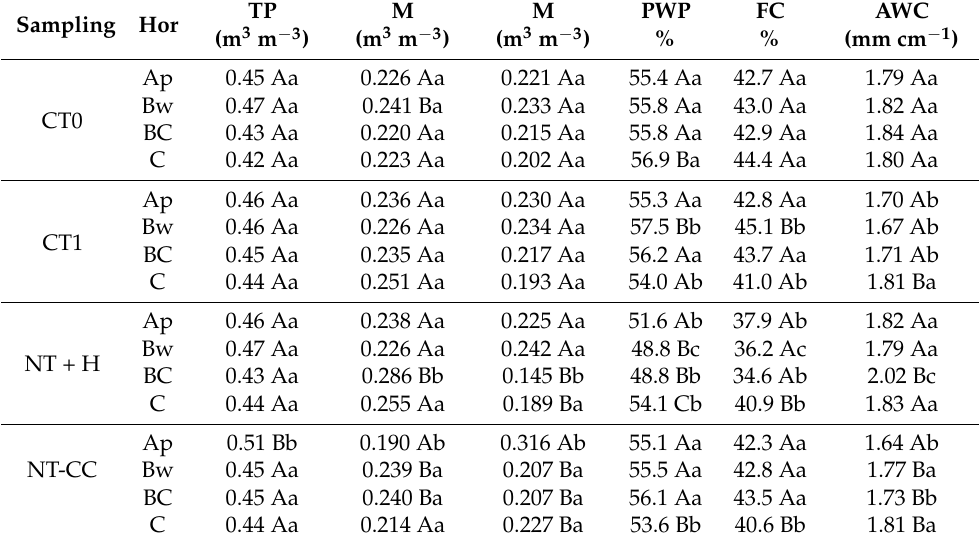
Table 2. Porosity and soil water retention properties at the three research plots (average ± SD) in Mediterranean olive groves. Initial situation (2004) and final situation (2019). Sampling